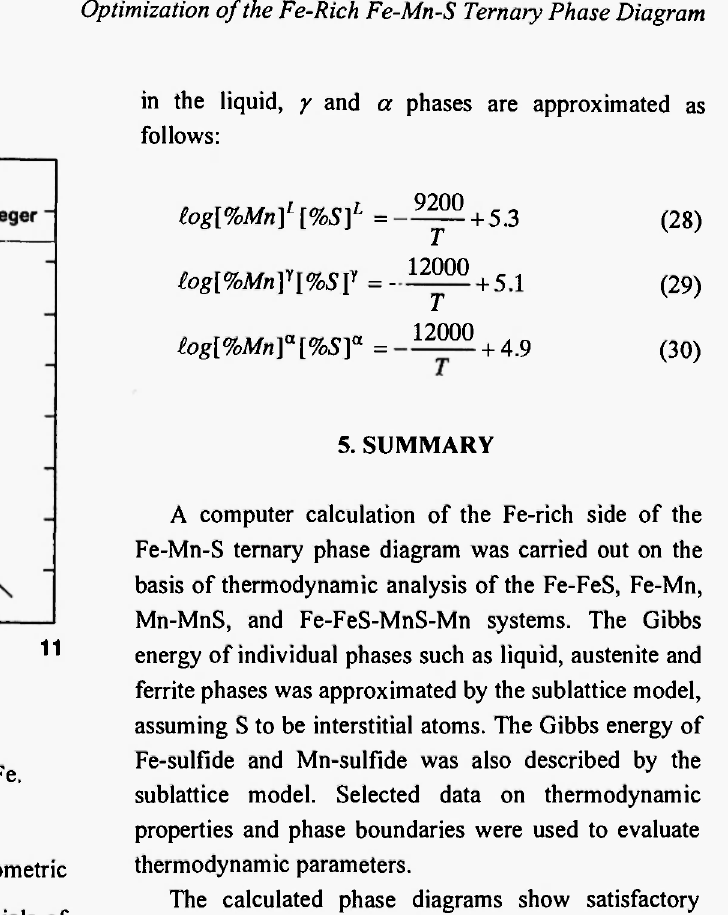
Fig. 12: Solubility products of Q-phase in